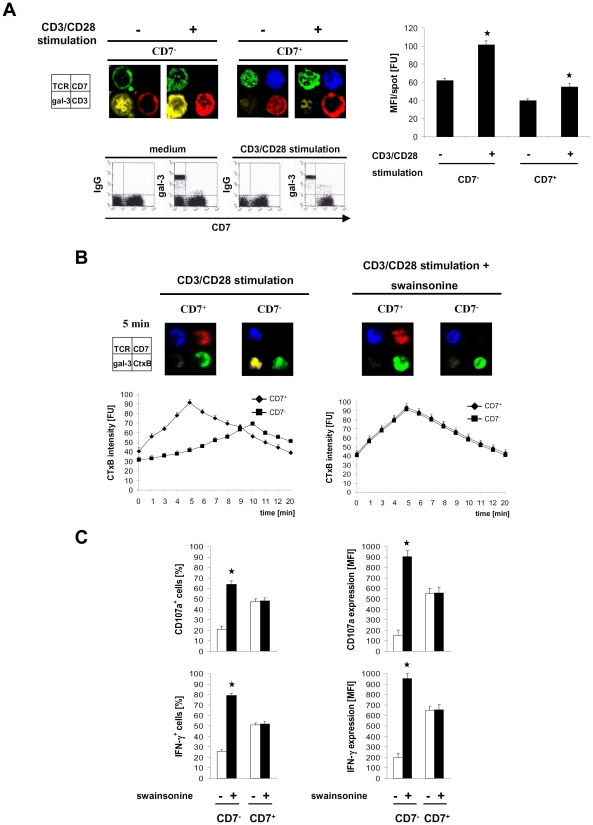
Galectin-3 prevents TCR synapse formation in late-stage T cells.(A) CD7− and CD7+ T cells were activated by incubation with anti-CD3 mAb plus anti-human CD28 mAb or as control by an isotype-matched IgG1 (medium). Cells were stained for TCR-alpha/beta (green), CD7 (blue), CD3 (red) and for galectin-3 (yellow). Immunofluorescence was visualized by a LSM. Alternatively cells were stained with mAbs specific to CD7 and subsequently recorded for gal-3 expression by staining with the anti-human gal-3mAb or as control by an isotype-matched IgG and analyzed by flow cytometry. A representative experiment out of five is shown. Galectin-3 specific signals were quantitatively recorded by a LSM as described in Materials and Methods. A minimum of 100 cells for each data point was recorded. (B) To monitor location of galectin-3 in lipid raft formation, isolated CD7− and CD7+ subsets of CD8+ CD45RO+ T cells were incubated with or without swainsonine for 24 hrs and then activated for various time intervals (1 min until 20 min) on coverslips coated with the agonistic anti-CD3 mAb plus anti-CD28 mAb. T cell stimulation was stopped with paraformaldehyde and cells were stained with anti-TCR-alpha/betamAb (blue), anti-CD7 mAb (red) and anti-galectin-3 mAb (yellow) together with CtxB (green) for lipid rafts staining. Immunofluorescence was visualized by a LSM and quantified as described in Materials and Methods. T cell staining after 5 min stimulation of one representative experiment out of five is exemplarily shown. (C) CD7− and CD7+ subsets of CD8+ CD45RO+ T cells were incubated with or without swainsonine and activated as described in (B). Frequencies of cells producing IFN-gamma and showing degranulation indicated by CD107a was monitored by flow cytometry. Data in Fig. 3 represent the mean ± SEM of five experiments and were compared using a paired t-test. * p<0.05. FU: fluorescence unit; MFI: mean fluorescence intensity.